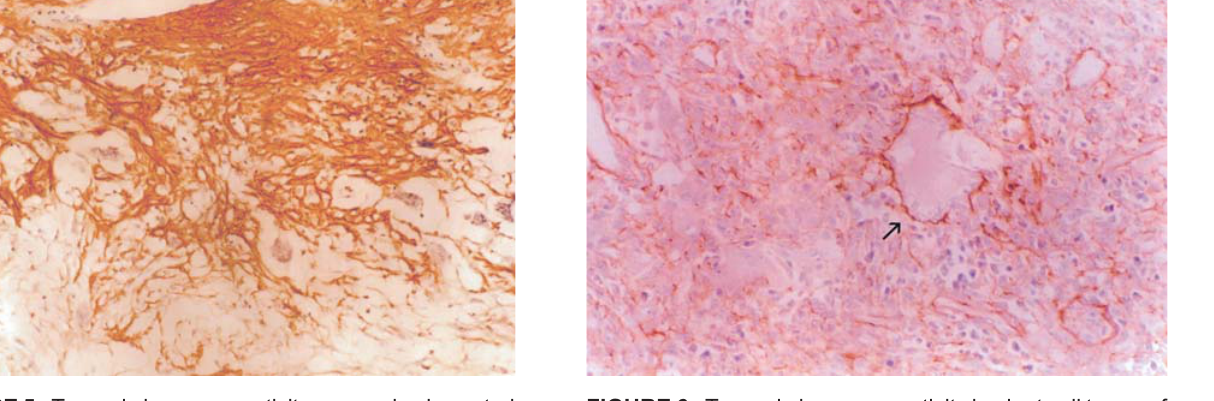
FIGURE 6 - Tenascin immunoreactivity in giant cell tumor of long bones. Reticulate organization pattern and positive staining around the basement membrane of blood vessels (arrow) (SABC –